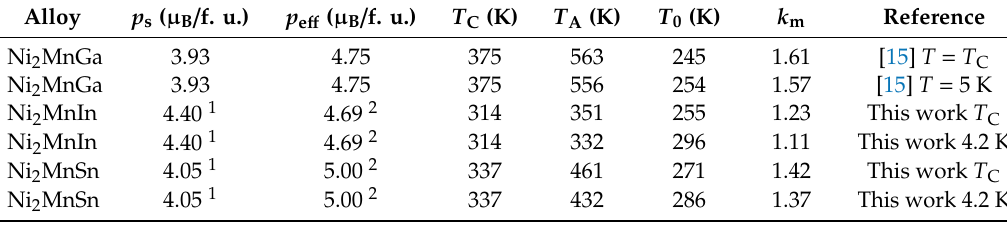
Table 1. Magnetic parameters of Ni 2 MnX (X = Ga, In, Sn). The spontaneous magnetic moment, p S ; effective moment, p eff ; Curie temperature, T C ; spin fluctuation parameter in k -space, T A ; spin fluctuation parameter in energy space, T 0 . The parameter k m was obtained from Equation (9), which was almost the same as k m = 1.4. “This work T C ” indicates the values obtained from the magnetization process measurements at T C , and “This work 4.2 K” indicates the values obtained from the magnetization process measurements at 4.2 K.